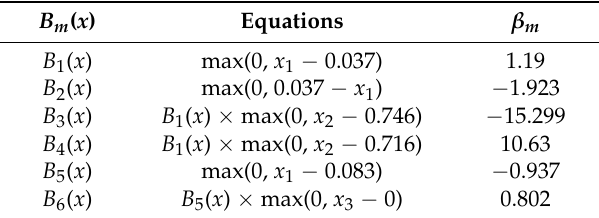
Table 2. Basis functions of y 1 and corresponding